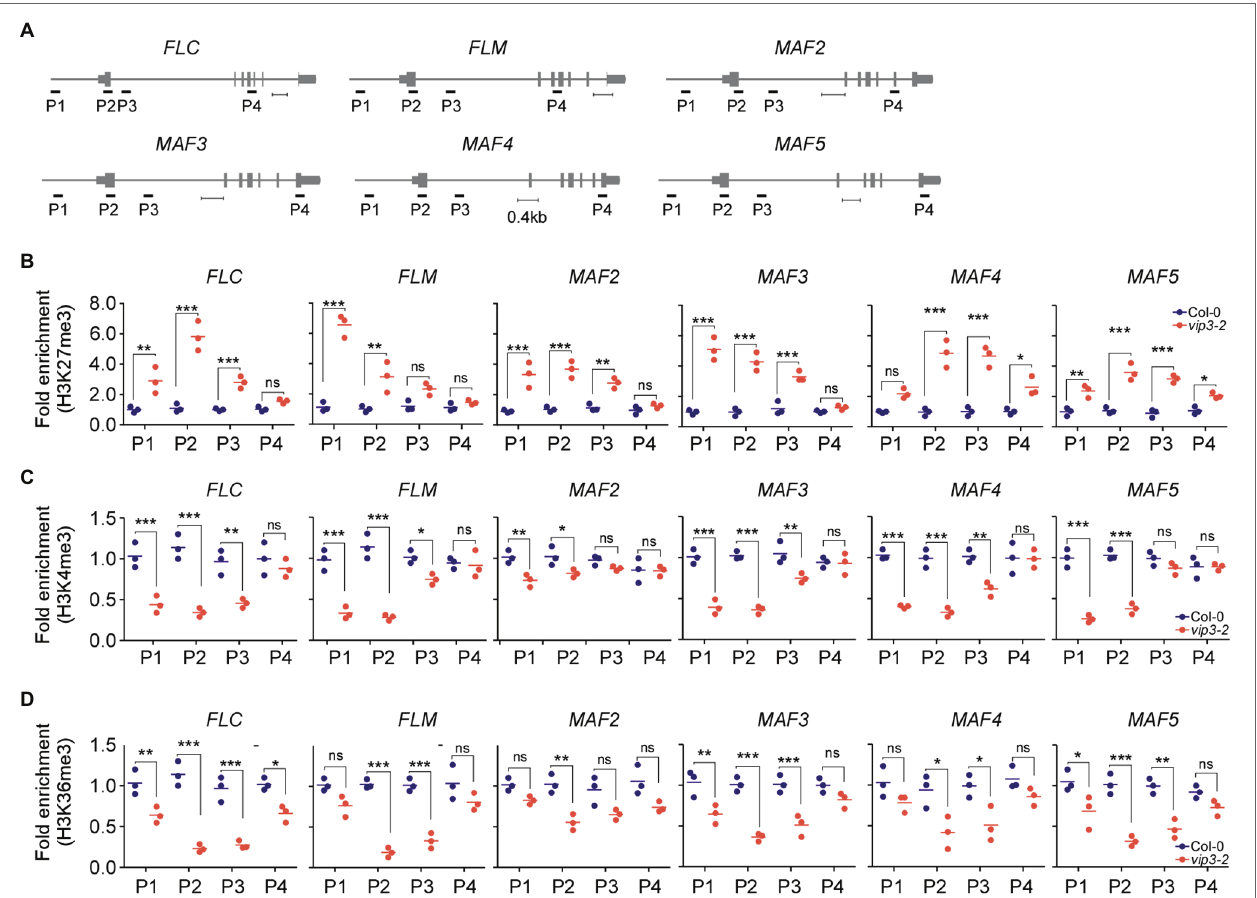
FIGURE 4 | Polymerase II–associated factor 1 complex deficiency alters the epigenetic status of chromatin of the FLC and the FLC -clade genes MAF1/FLM and MAF2–MAF5 . (A) Schematic representation of the genomic regions of FLC and FLC -clade genes and the regions amplified for chromatin immunoprecipitation (ChIP) assays. Scale bar = 0.4 kb. Note that our P2 region in FLC partially overlaps with the region that was used in a previous study (He et al., 2004). In the case of FLM , our P2 region is included in a region that was previously shown to be affected (He et al., 2004). (B–D) Fold enrichment of the repressive epigenetic H3K27me3 marks (B) , permissive H3K4me3 marks (C) , and permissive H3K36me3 marks (D) at the genomic regions of FLC and FLC -clade genes in wild-type (Col-0) and PAF1C-deficient vip3 mutant seedlings. For each primer pair, the enrichment was normalized to the wild-type control (Col-0). One-way ANOVA followed by